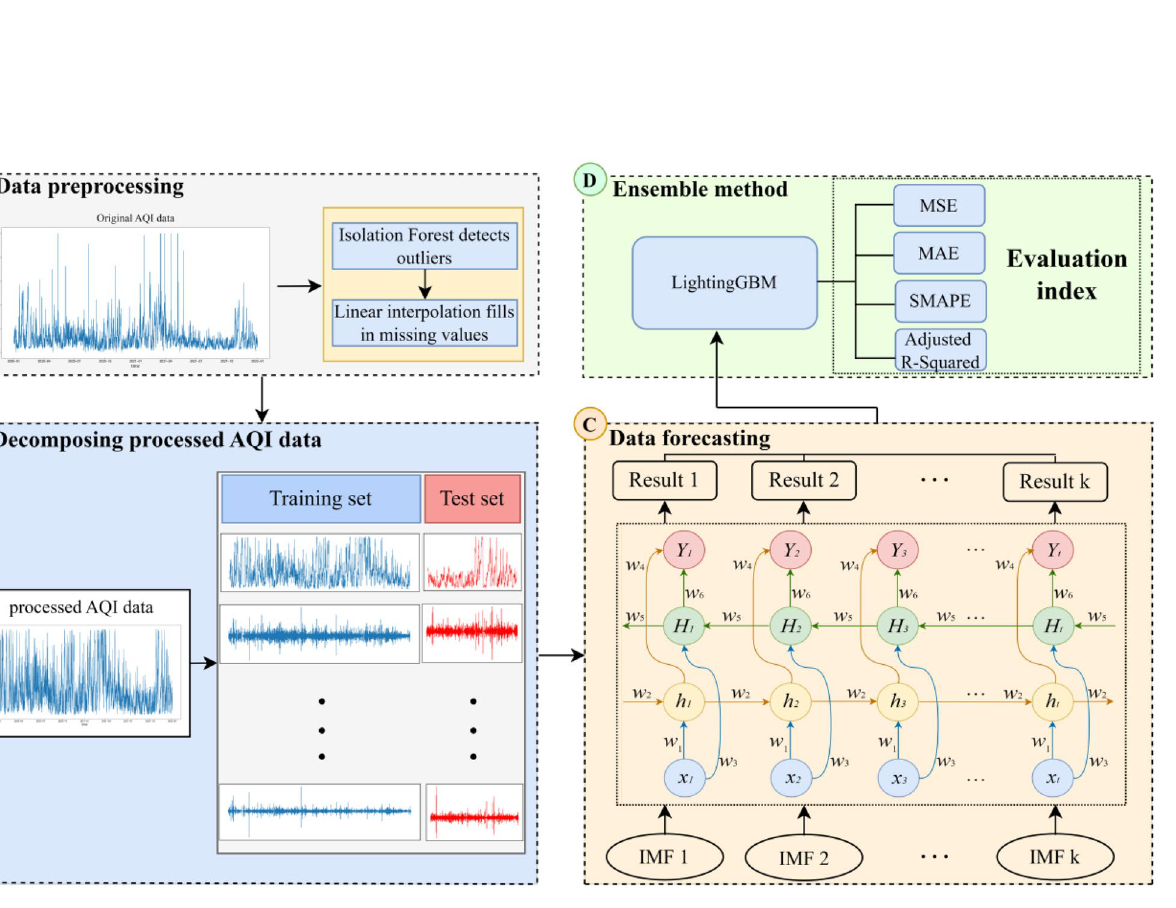
Figure 3. SSA-BiLSTM-LightGBM model